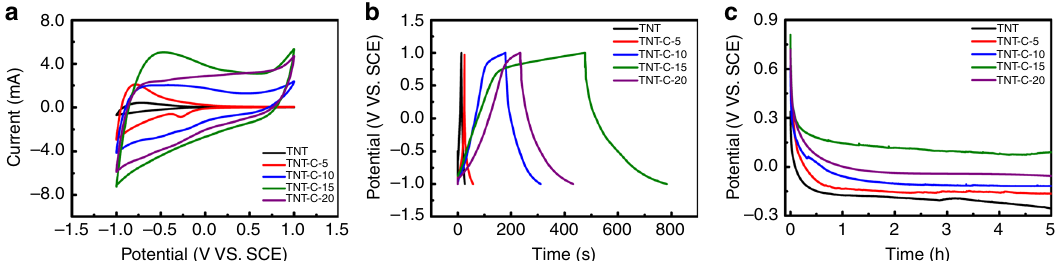
Fig. 2 Electrochemical performance. a CV and b GCD curves acquired at a scanning rate of 100 mV s − 1 and current density of 2.5 mA cm − 2 , respectively. c Potential of samples with time after charging to